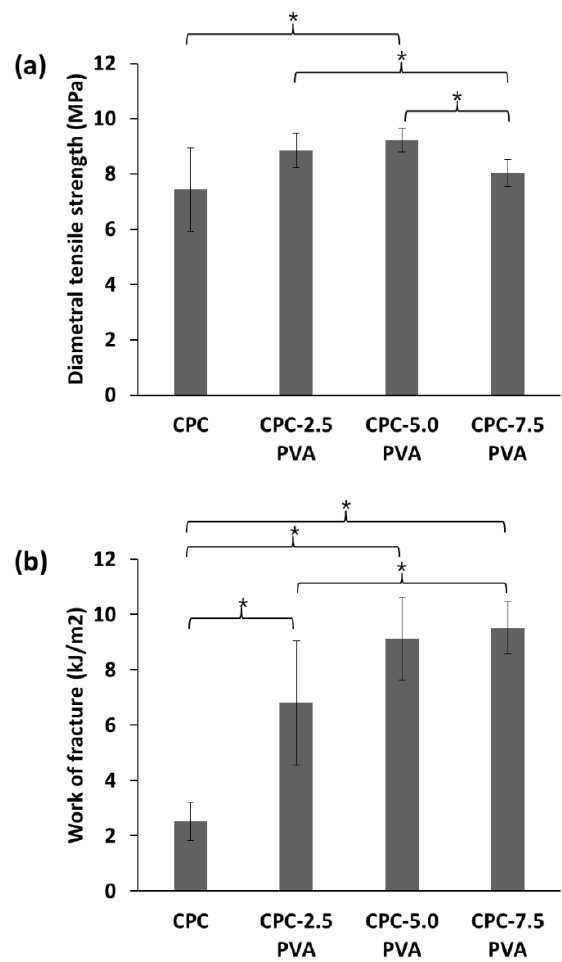
Figure 3. Mechanical properties of the cements from diametral tensile strength (DTS) tests. ( a ) Diametral tensile strength; ( b ) work of fracture. * Statistically significant difference (ANOVA, Scheffe’s post-hoc test, p < 0.05).